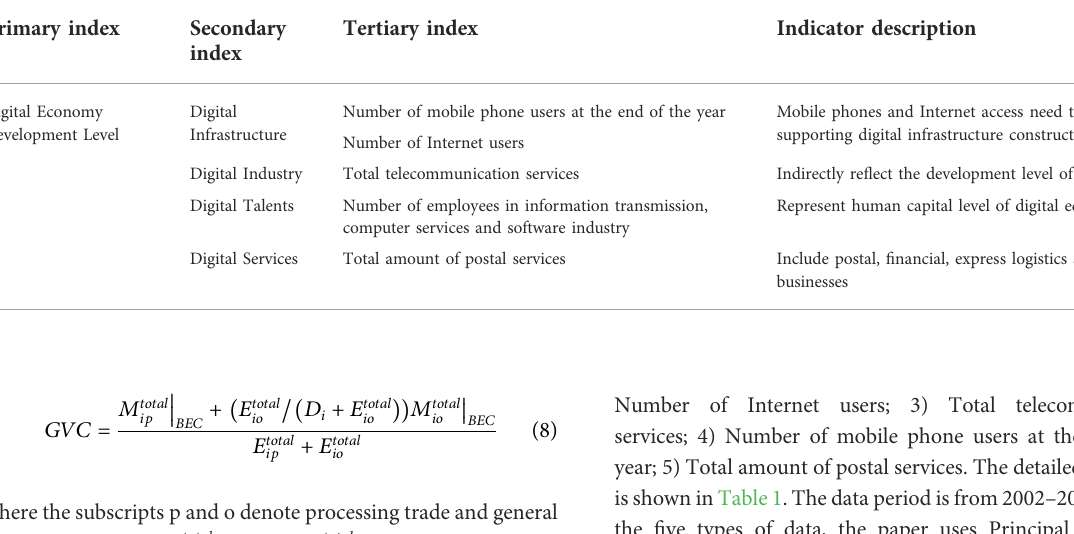
TABLE 1 Description of digital economic data